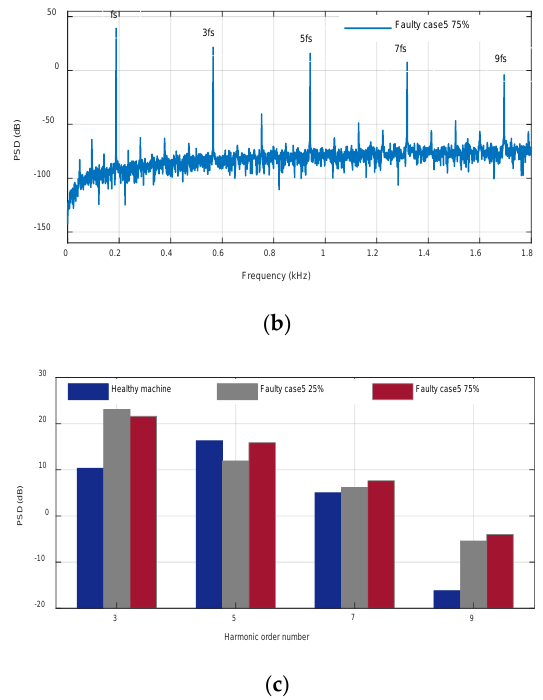
Figure 27. Faulty case 5 ( a ): PMSM current spectra normalized plot under 25%; ( b ) PMSM current spectra normalized plot under 75%; ( c ) ASBCs harmonics variations.